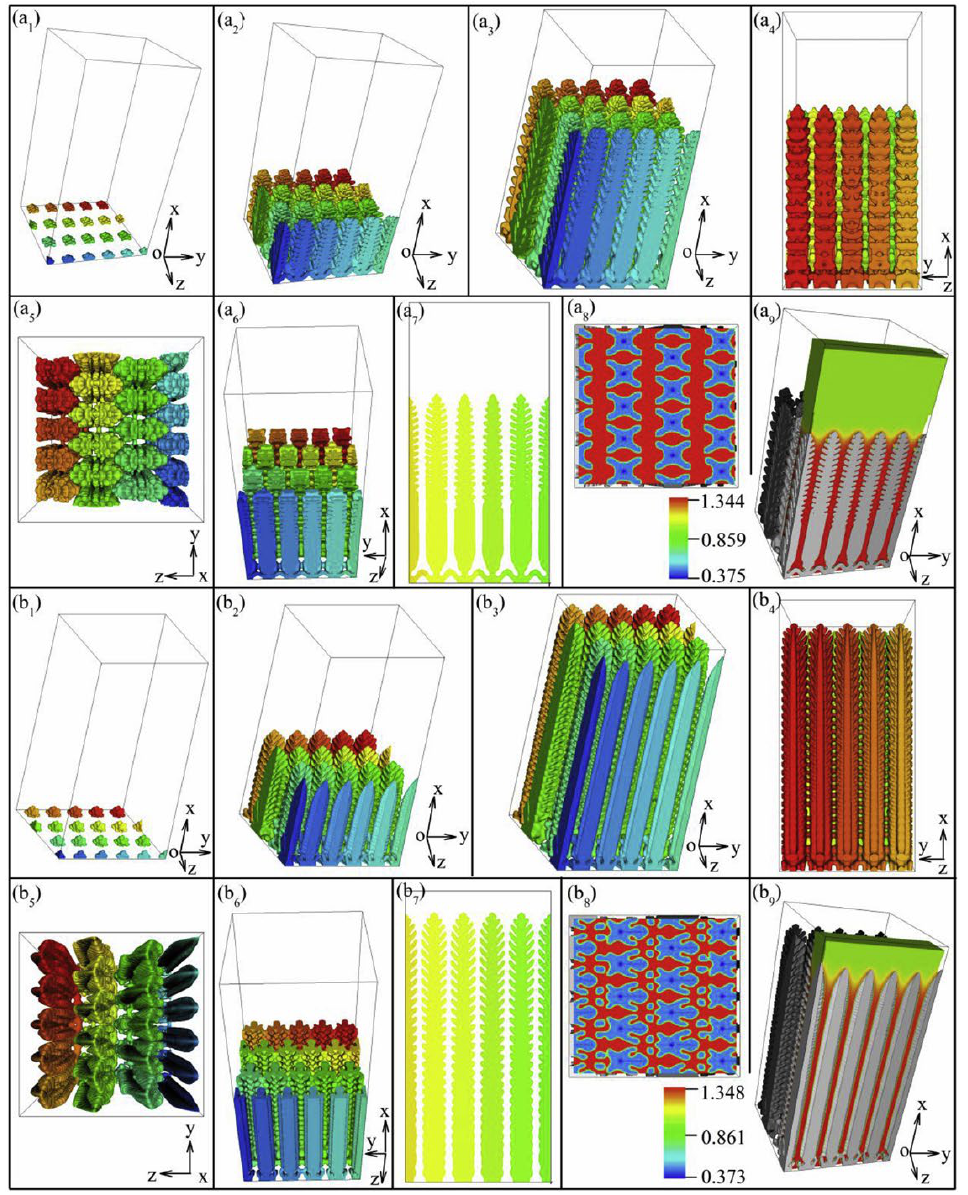
Figure 8. The 3D dendritic morphology evolution at the time step of ( a 1 , b 1 ) 2000, ( a 2 , b 2 ) 24,000, and ( a 3 , b 3 ) 60,000. The 3D growth pattern at the 56,000 time step viewed from <0001>, <1010> and <1011> is shown in ( a 4 , b 4 ), ( a 5 , b 5 ) and ( a 6 , b 6 ), while the relevant 2D dendritic pattern projected in the xoy section is shown in ( a 7 , b 7 ). ( a 8 , b 8 , a 9 , b 9 ) are the solute concentration fields [91]. On the basis of this investigation, they further interpreted the influence of multiple factors such as anisotropy, cooling rate, temperature gradient, and orientation angle on the growth of columnar crystals [93]. The simulation results show that the increase of anisotropy, cooling rate, and temperature gradient, can accelerate the growth rate of columnar dendrites. In contrast, the growth rate of columnar dendrite slows down with the increase of the orientation angle. Meanwhile, the primary dendrite spacing decreases with the increase of cooling rates and temperature gradient, while the primary dendrite spacing increases with the increase of anisotropy and orientation